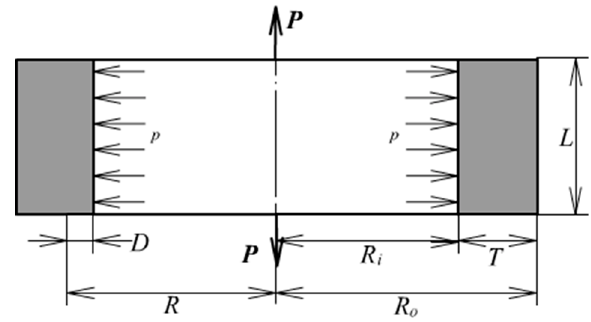
Figure 1. A thick-walled cylinder.